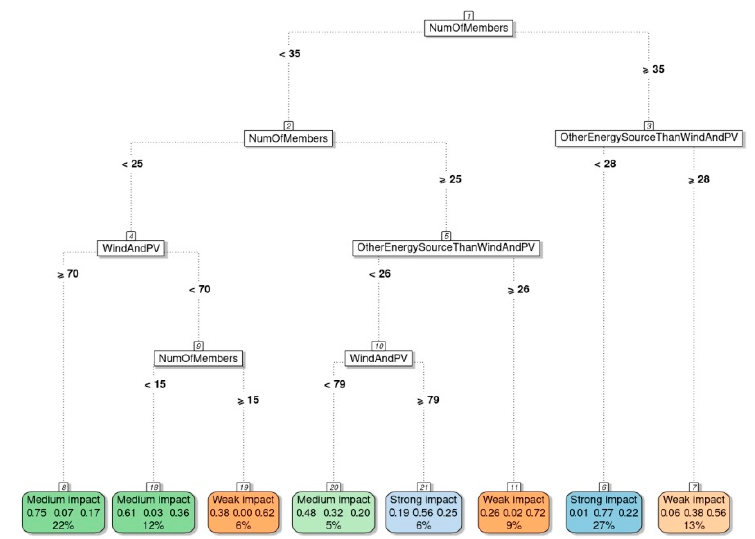
Figure 4. Decision tree quantifying the magnitude of potential benefits after the implementation of a battery corresponding to the “half effect” relative to the distribution of sources and number of members. Table 5. Decision-tree rules quantifying the magnitude of potential benefits after the implementation of a battery corresponding to the “half effect” relative to the distribution of sources and number of members. The color scheme used in column two corresponds to that of the leaves in Figure 4. NumOfMembers < 35 and NumOfMembers ≥ 25 and Weak Im- OtherEnergySourceThanWindAndPV ≥